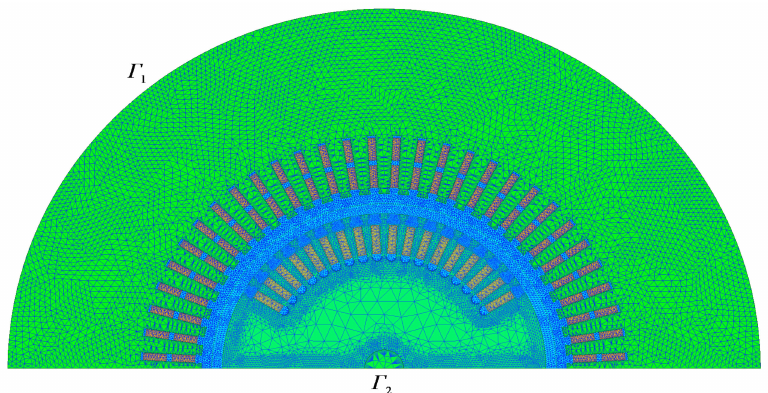
Figure 5. The field-circuit synchronous generator model with a visible finite element